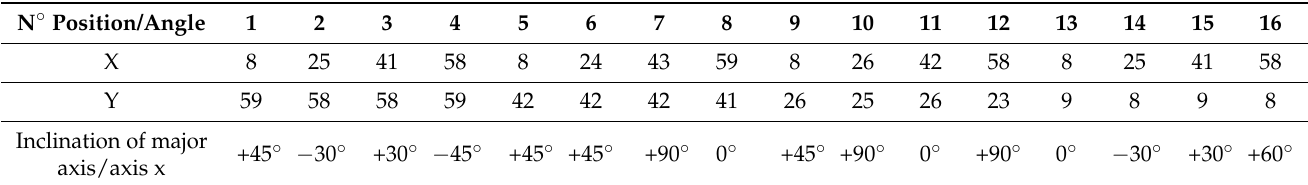
Figure 1. ( a ) Typical underwater picture with the organization of the specimen; ( b ) corresponding elliptical shape with major and minor axis: purple (0°), green (+/ − 30°), black (+/ − 45°), blue (+/ − 60°) and red (90°); ( c ) using the aksi3D ® system (tested at IFREMER). Table 1. Position of the center and inclination of each specimen.